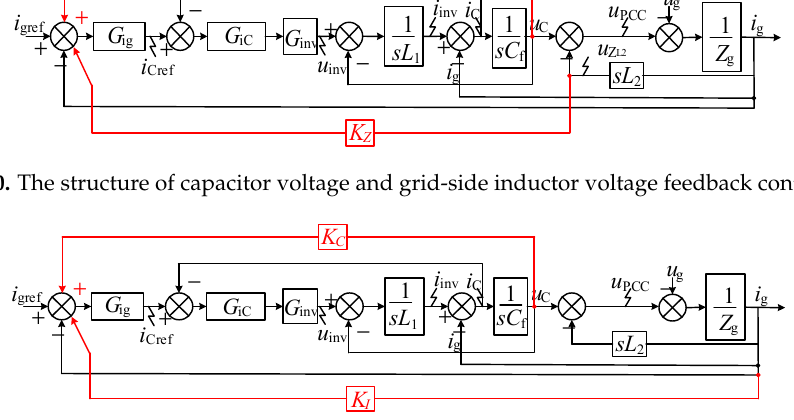
Figure 11. The structure of capacitor voltage and grid current feedback control loop.